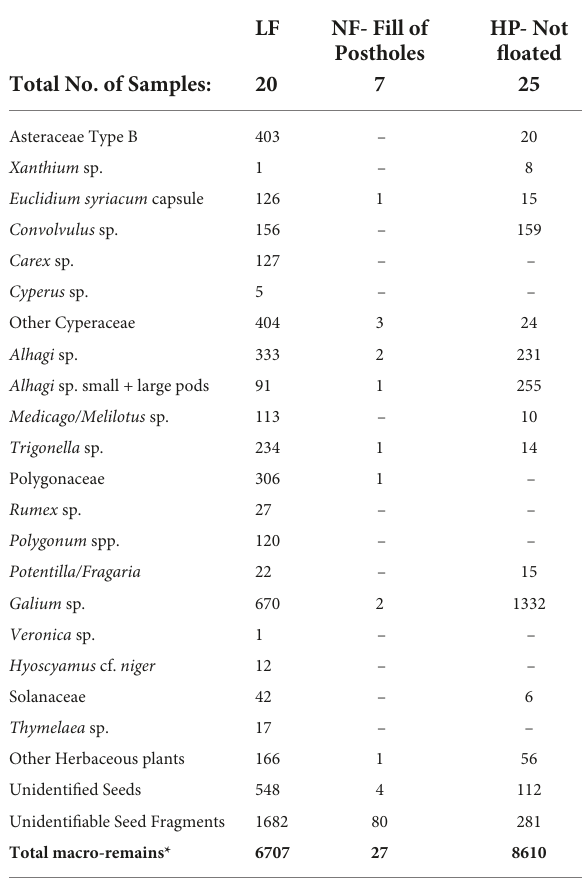
TABLE 1 Summary of total counts for the assemblage separated by sample collection type (LF, light fraction; NF, not floated, fill from postholes; HP, not floated,